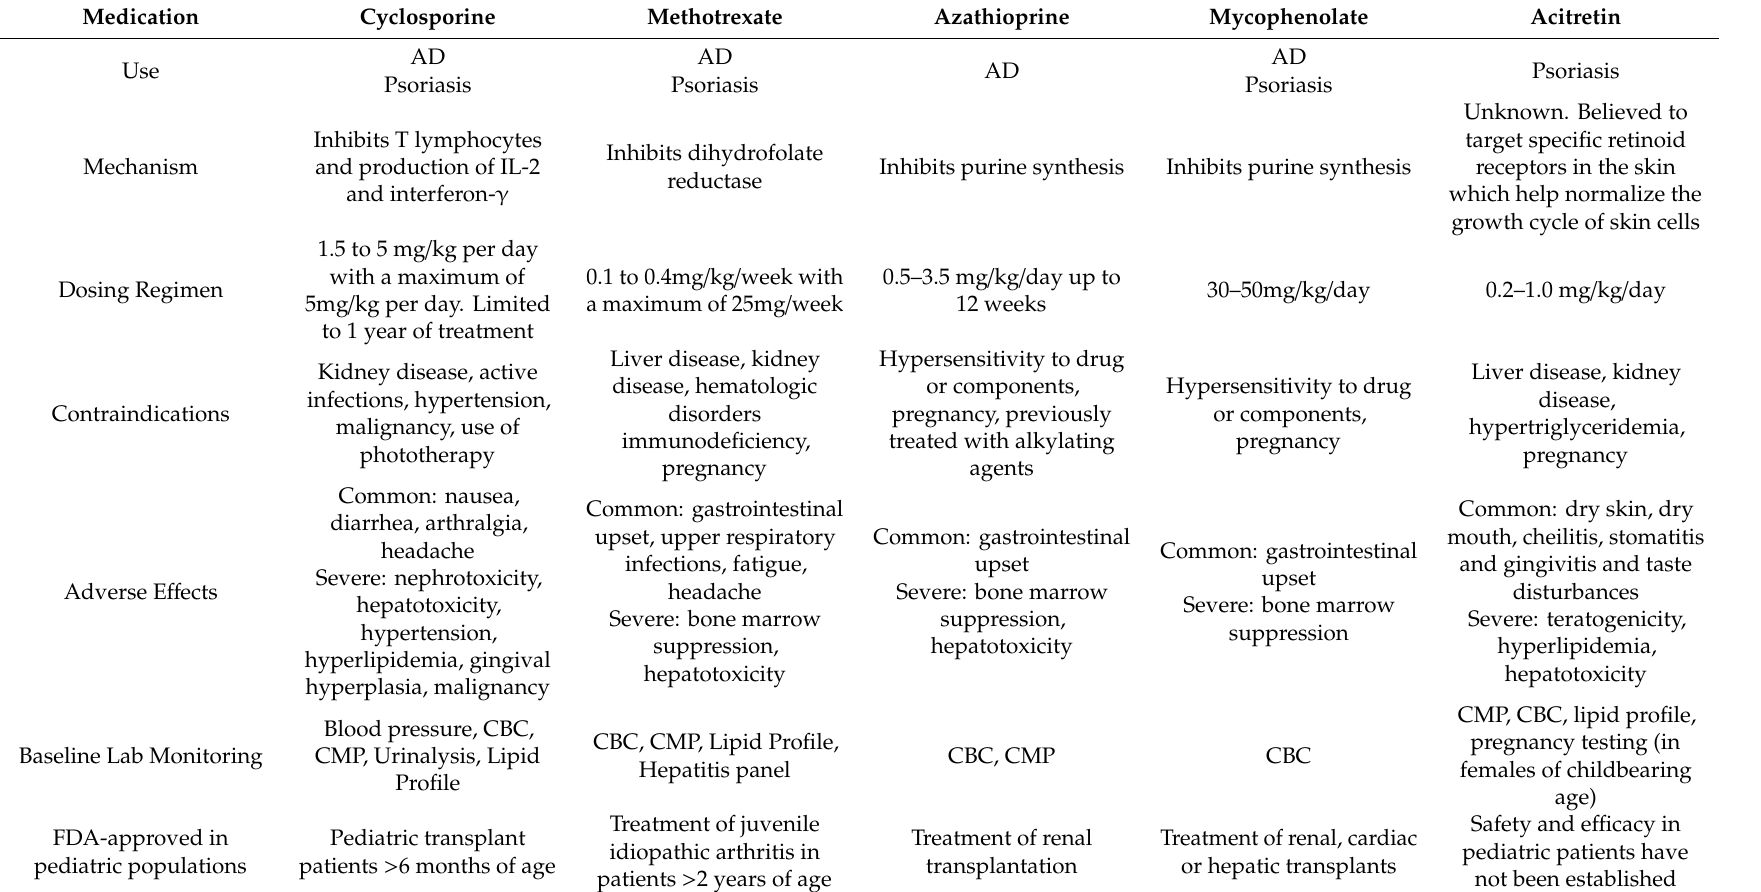
Table 3. Oral treatments in pediatric atopic dermatitis and psoriasis